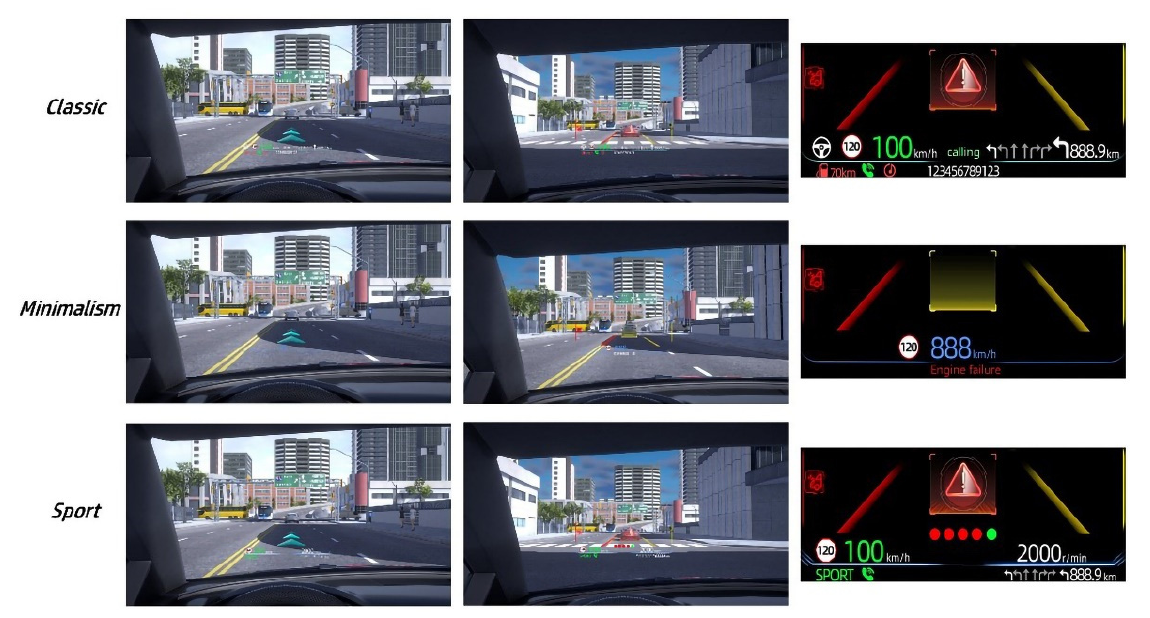
Figure 2. HUD interface design scheme 1. This scheme adopts the solid boomerang navigation icon. The arrow thickness is appropriately increased in the design and the light and shadow effect is added to make it visually more stereoscopic. As for the WSP (warning system for pedestrians) and FCWS (forward collision warning system) design, the icons are designed in the form of squares as a whole and the specific presentation forms change with the different HUD system modes, e.g., in minimalism mode, only one semi-transparent warning rectangle is displayed.